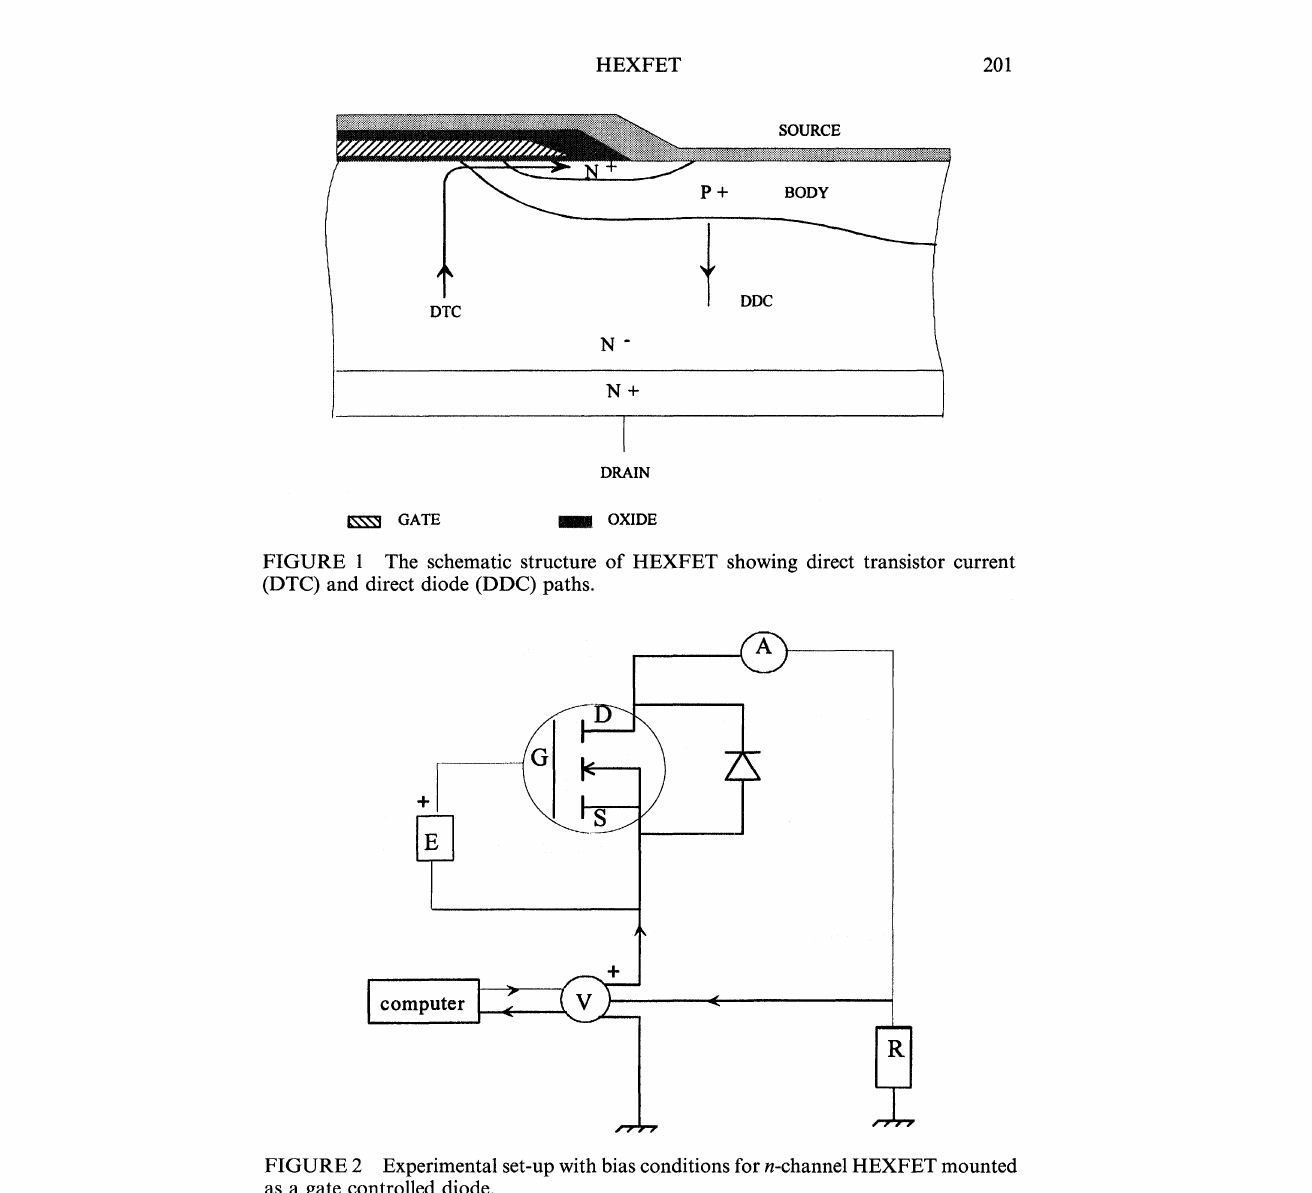
FIGURE 2 Experimental set-up with bias conditions for n-channel HEXFET mounted as a gate controlled